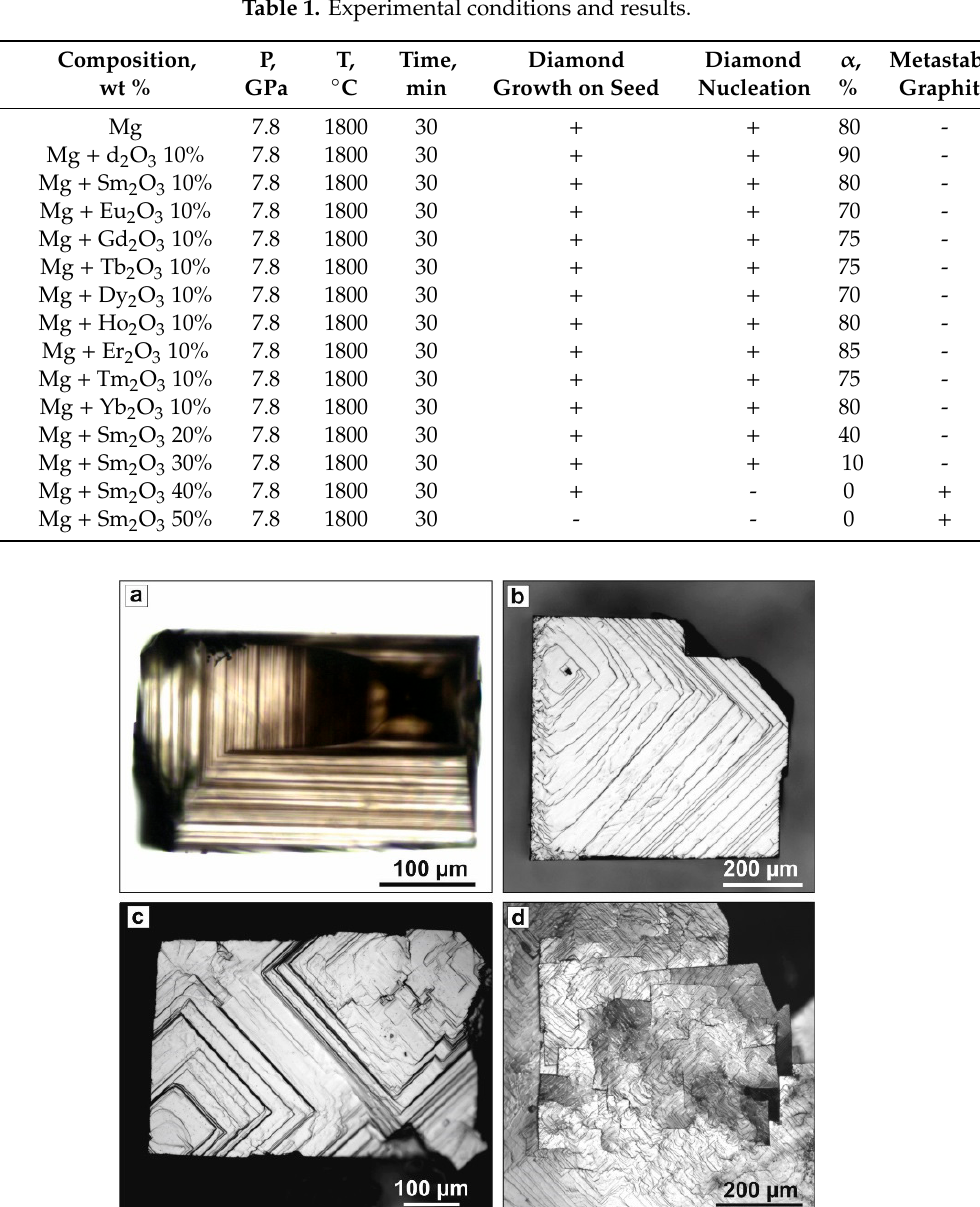
Table 1. Experimental conditions and results.